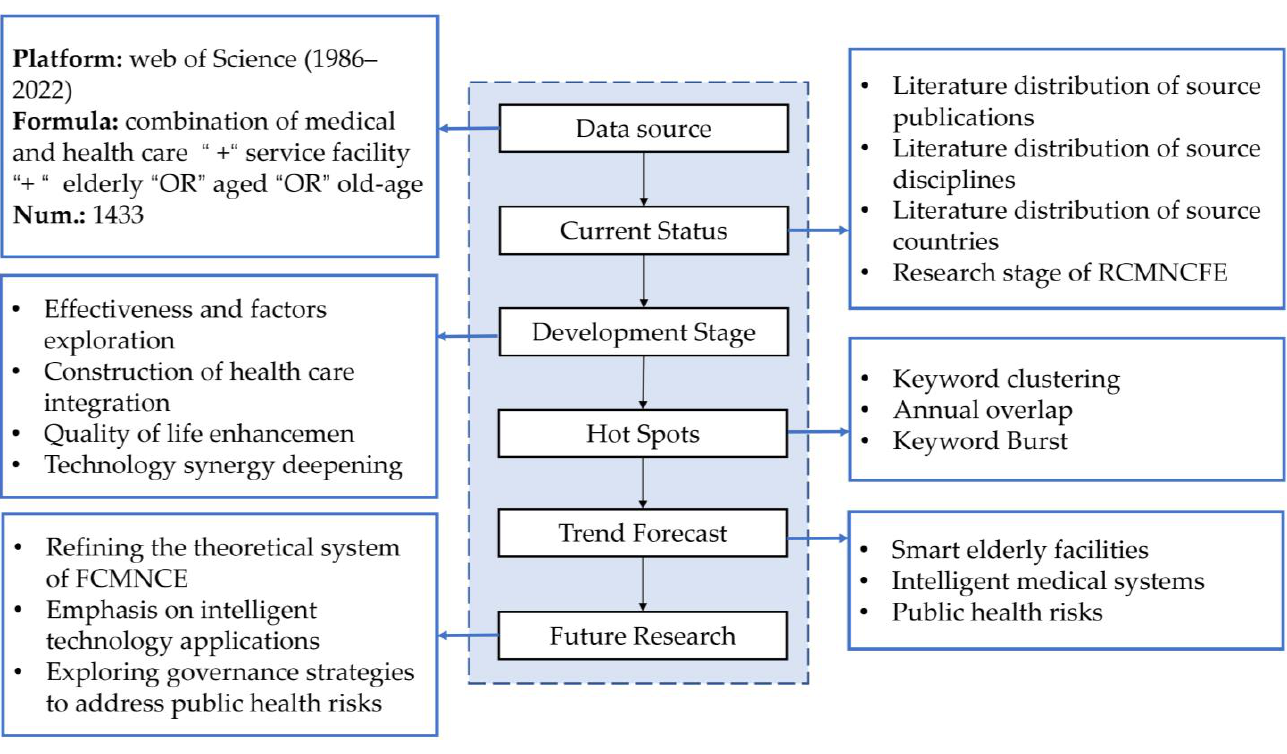
Figure 2. Outline of FCMNCE research design.